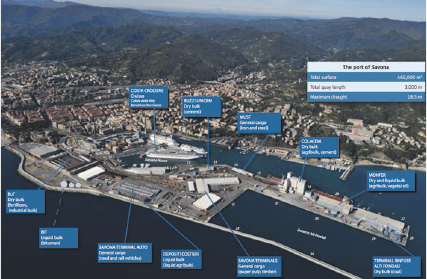
Figure 1: Port of Savona (Savona Port Authority, 2010) [25].